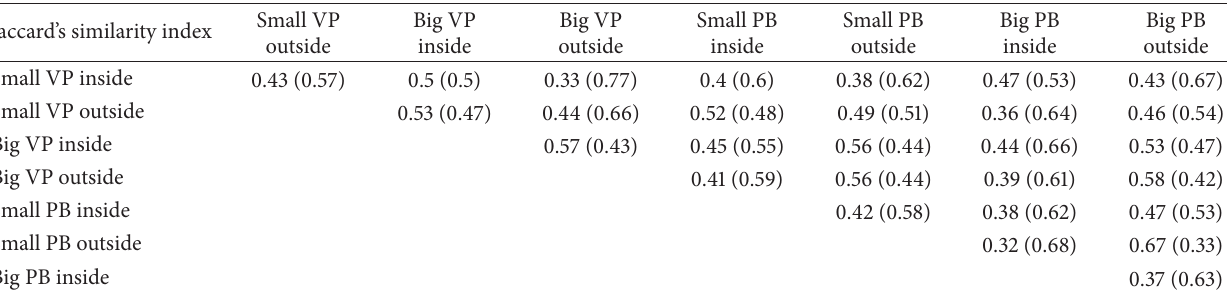
Table 5: Half matrix of similarity and dissimilarity (in parenthesis) of species composition among inside and outside crown zones of the tree of different sizes. PB: P. biglobosa ; DO: D. oliveri ; VP: V. paradoxa . Small Jaccard’s similarity index